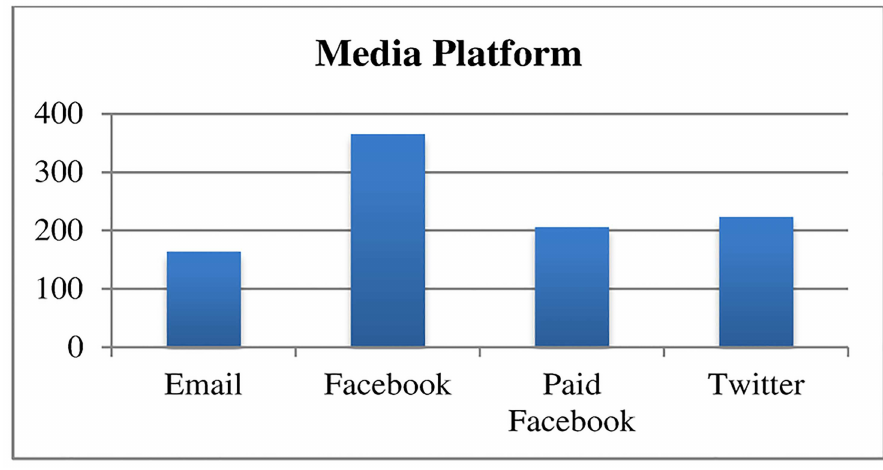
Fig 3. Estimated number of clicks by social media platform to landing site for a hypothetical campaign of six messagessent to